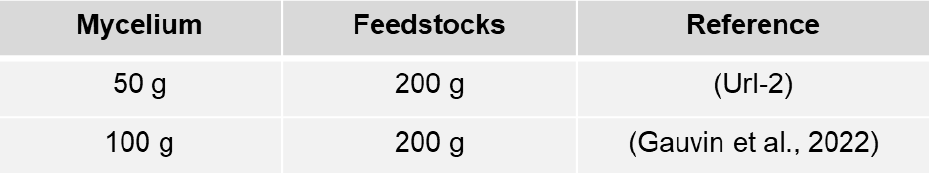
Table 3 Mycelium Composite Mixing Ratios of Reference